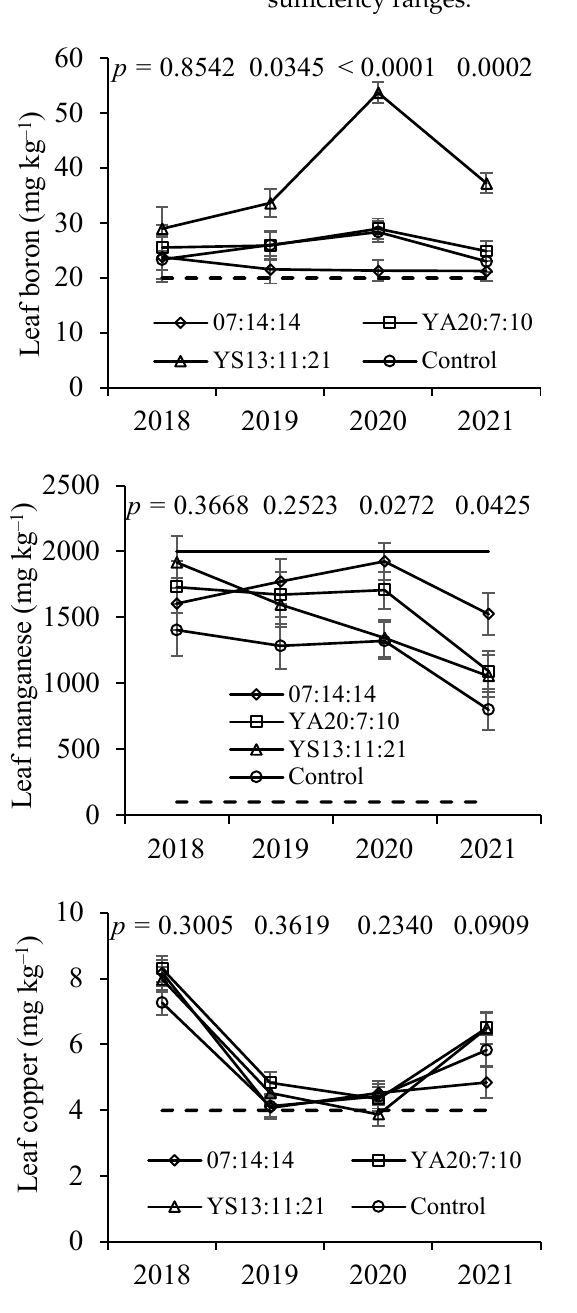
Figure 4. Leaf concentration of boron, iron, manganese, zinc and copper as a response to fertilisation treatments. Dashed and solid lines are, respectively, the lower and upper limits of the sufficiency ranges. Error bars are the standard errors.